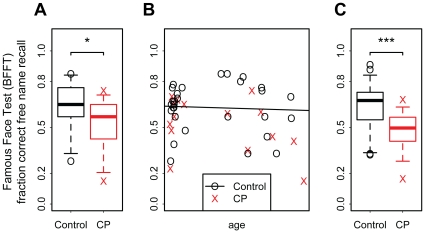
Bielefeld Famous Face Test.(A) Compared to controls, CPs showed worse recognition performance in free name recall. (B) Performance is influenced by confounding factors, e.g. age. (C) After accounting for confounding factors, performance differences between CPs and controls are more pronounced.